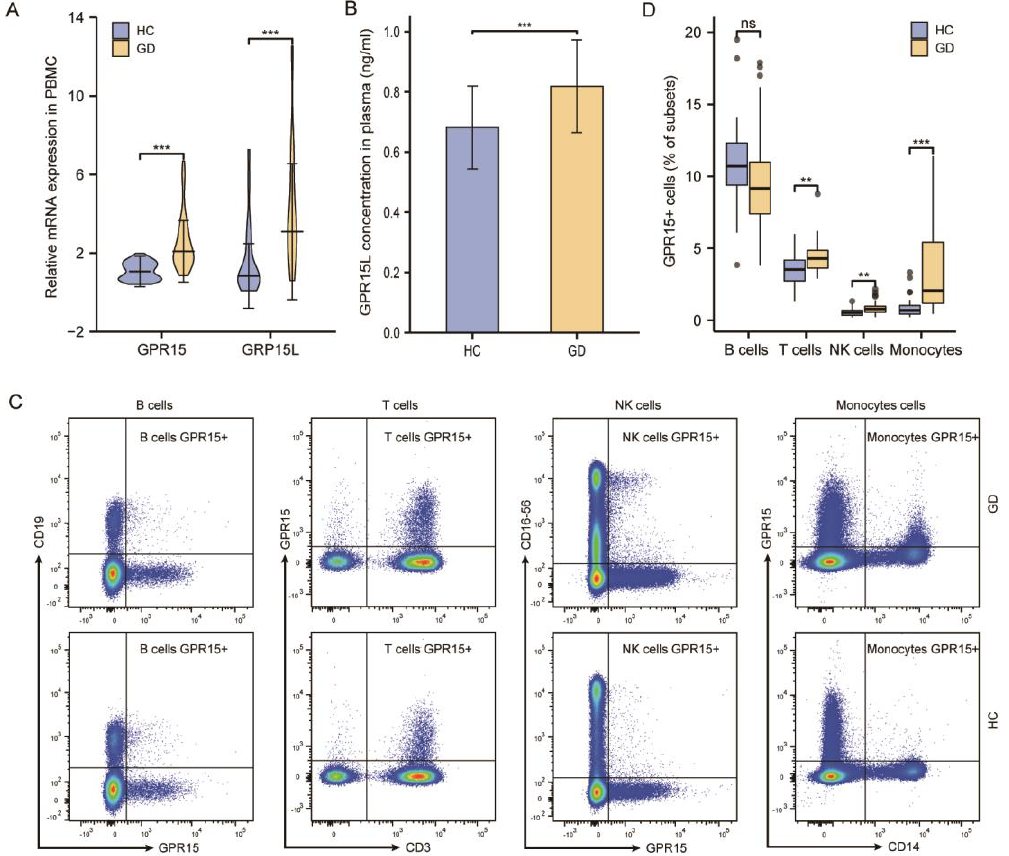
Figure 1. GPR15 and GPR15L expression levels are elevated in patients with GD. ( A ) Relative mRNA expression of GPR15 and GPR15L in PBMC. ( B ) GPR15L concentration in plasma. ( C ) Representative flow cytometric plots of GPR15 expression by B cells (CD19+), T cells (CD3+), NK cells (CD16-56+), and Monocytes (CD14+). ( D ) Percentage of GPR15+ of B cells (CD19+), T cells (CD3+), NK cells (CD16-56+), and Monocytes (CD14+). (ns, p ≥ 0.05; **, p < 0.01; ***, p < 0.001; HC: healthy controls, GD: Graves’